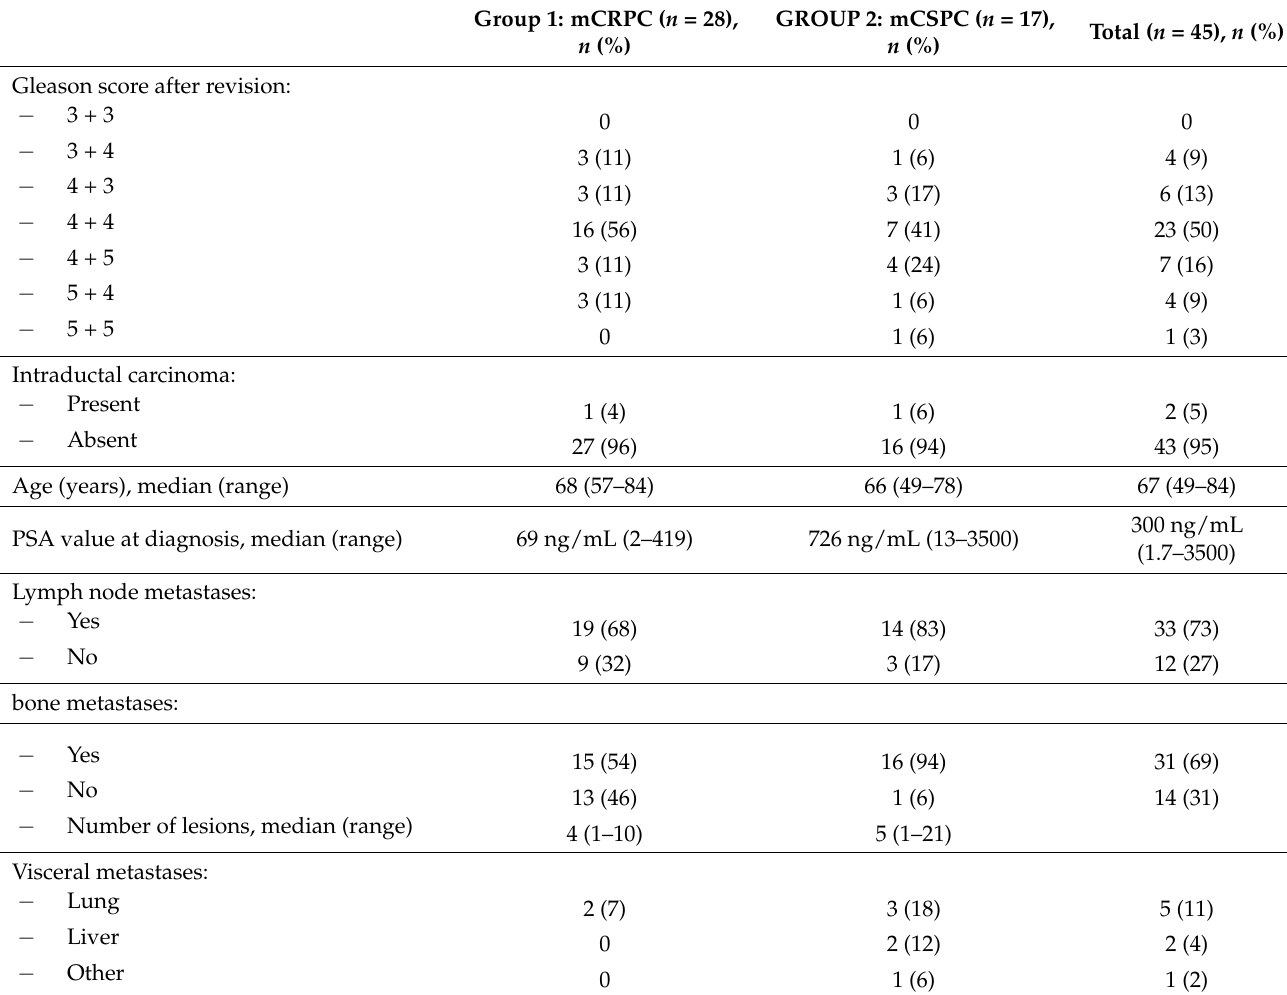
Table 4. Characteristics of patients with a cribriform